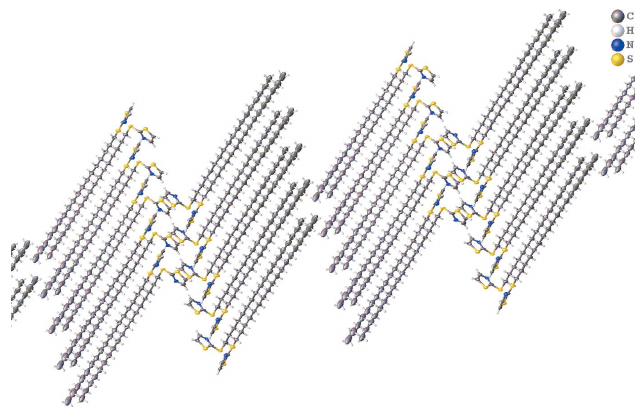
Figure 2 Packing diagram for the title compound depicting the alkyl chain interactions between molecules.